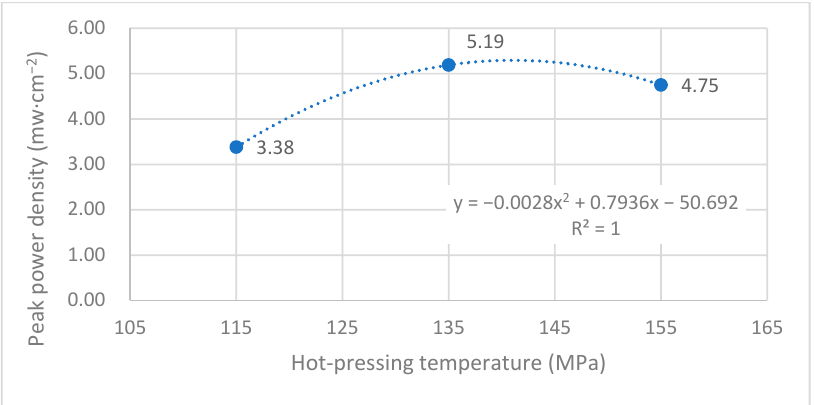
Figure 24. The fitting curve of the peak power density of MEA at a different hot-pressing temperature under room temperature and oxygen conditions.